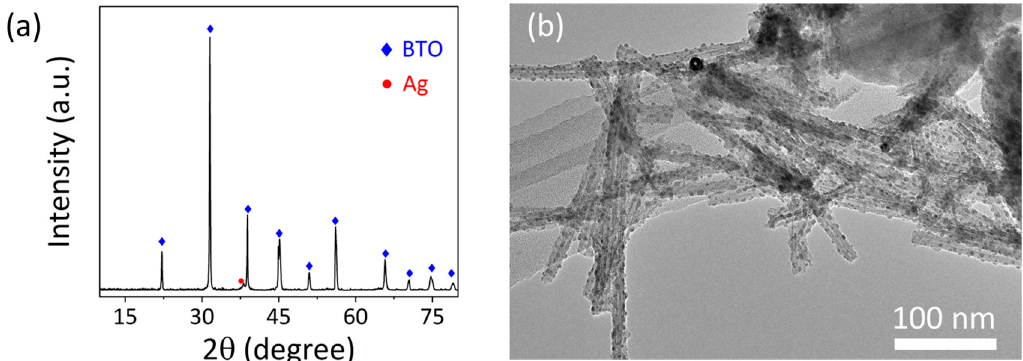
Figure 7. ( a ) XRD pattern and ( b ) TEM image of Ag-BTO-2 after